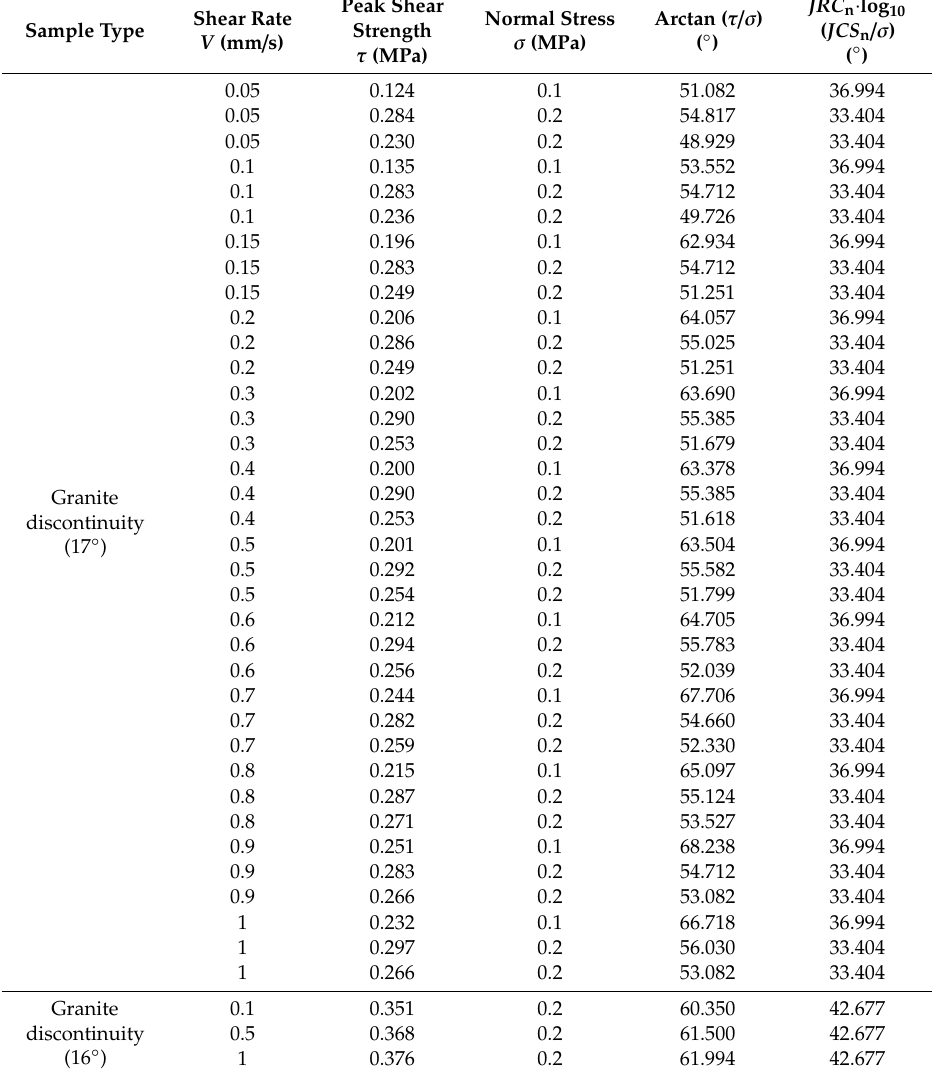
Table A2. Test data of di ff erent granite discontinuity samples with the shear rate varying from 0.03 mm / s to 1 mm /